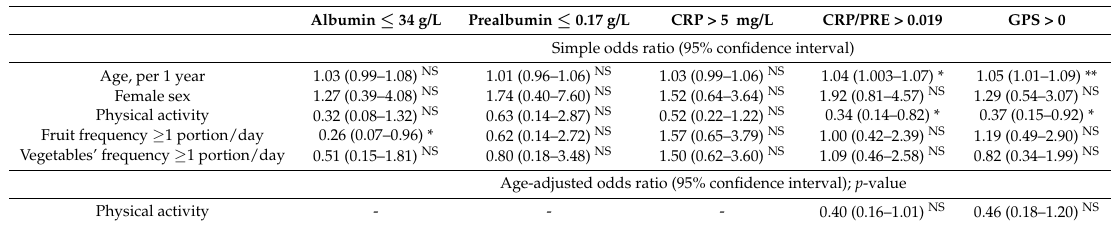
Table 4. The results of simple and age-adjusted logistic regression performed to identify predictors of malnutrition and inflammation.